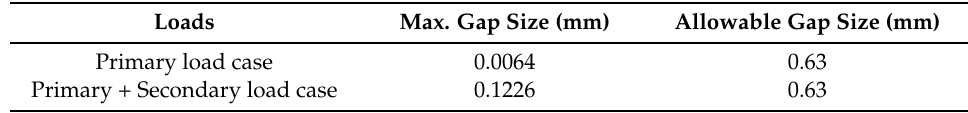
Table 3. Gap result evaluation of the TLIC door sealing design.